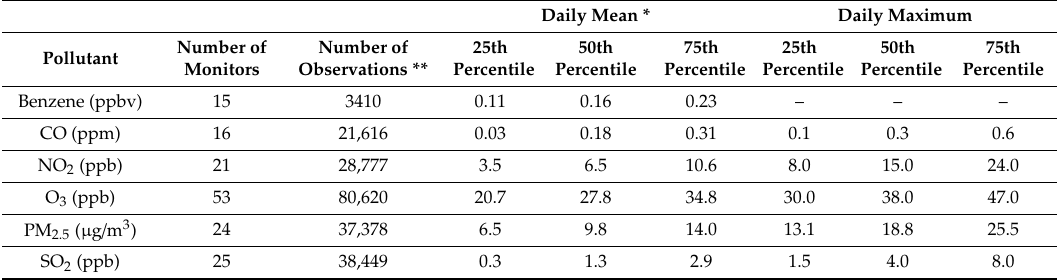
Table 1. Number of monitoring sites and quartiles of daily mean and maximum concentrations by pollutant, all Pennsylvania monitoring sites except Philadelphia-metropolitan area, in 2011–2015. The quartiles of mean concentrations were used as cut-points to define very low, low, medium and high exposure categories based on air monitoring data. Daily Mean * Daily Maximum